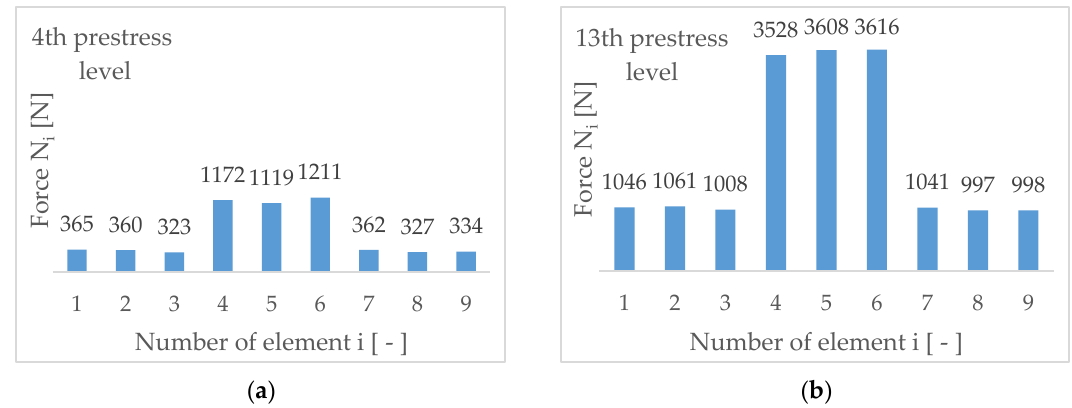
Figure 4. The experimental distribution of member forces for the prestress levels: ( a ) the 4th level; ( b ) the 13th level.